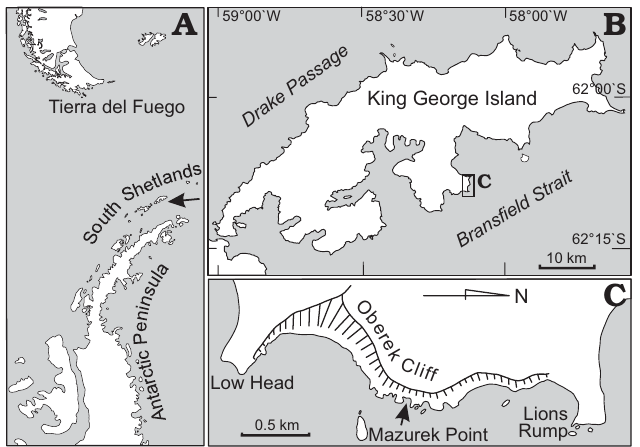
Fig. 1. A . Map of Antarctic Peninsula area, arrow shows position of King George Island in South Shetland Islands archipelago. B . King George Island showing location of the study area. C . Low Head–Lions Rump area, arrow shows position of Pholadidea gradzinskii sp. nov. horizons at Mazurek Point (after Ga ź dzicki et al. 1982).